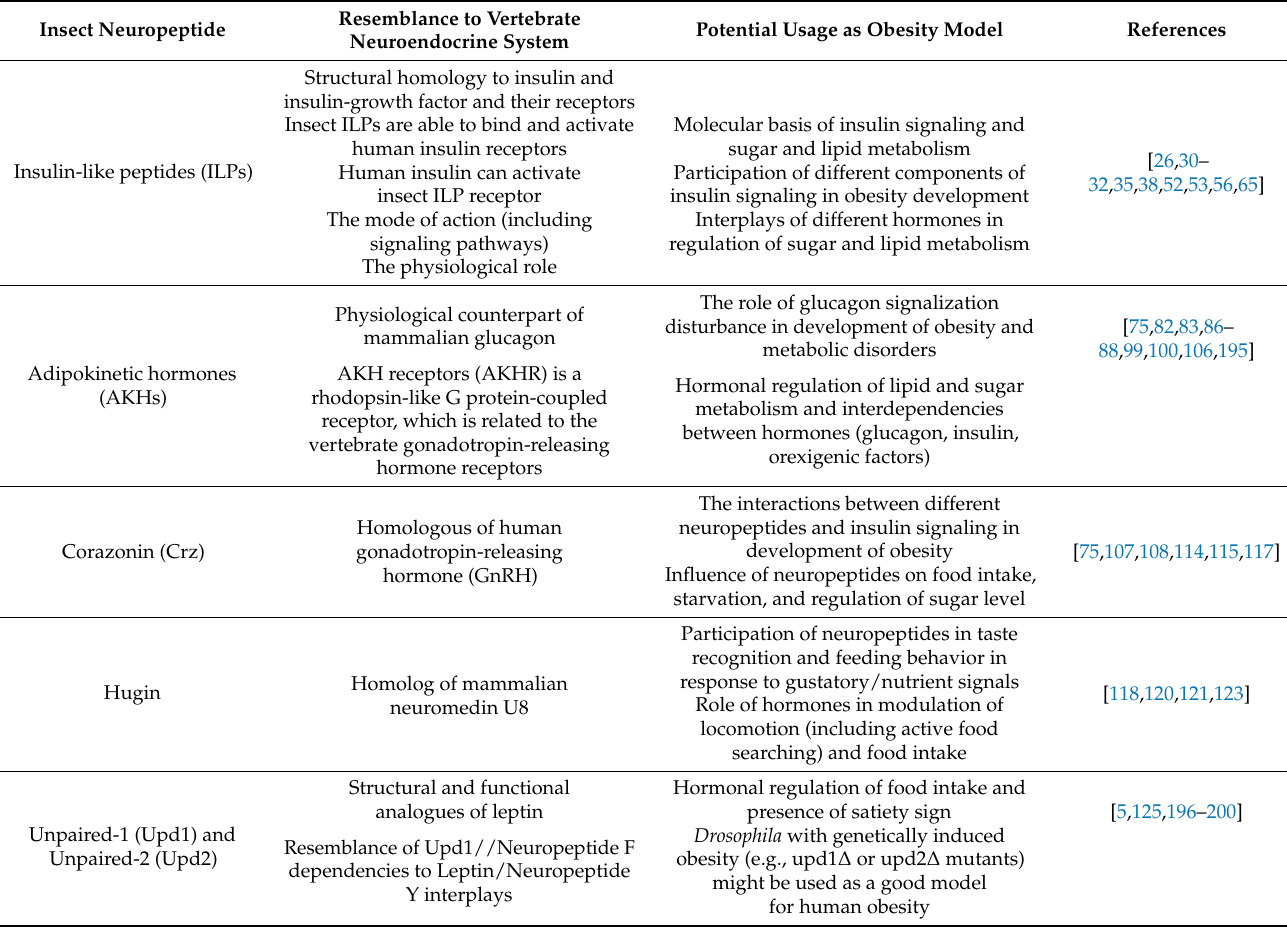
Table 1. Insect neuropeptides, its resemblance and potential usage as obesity